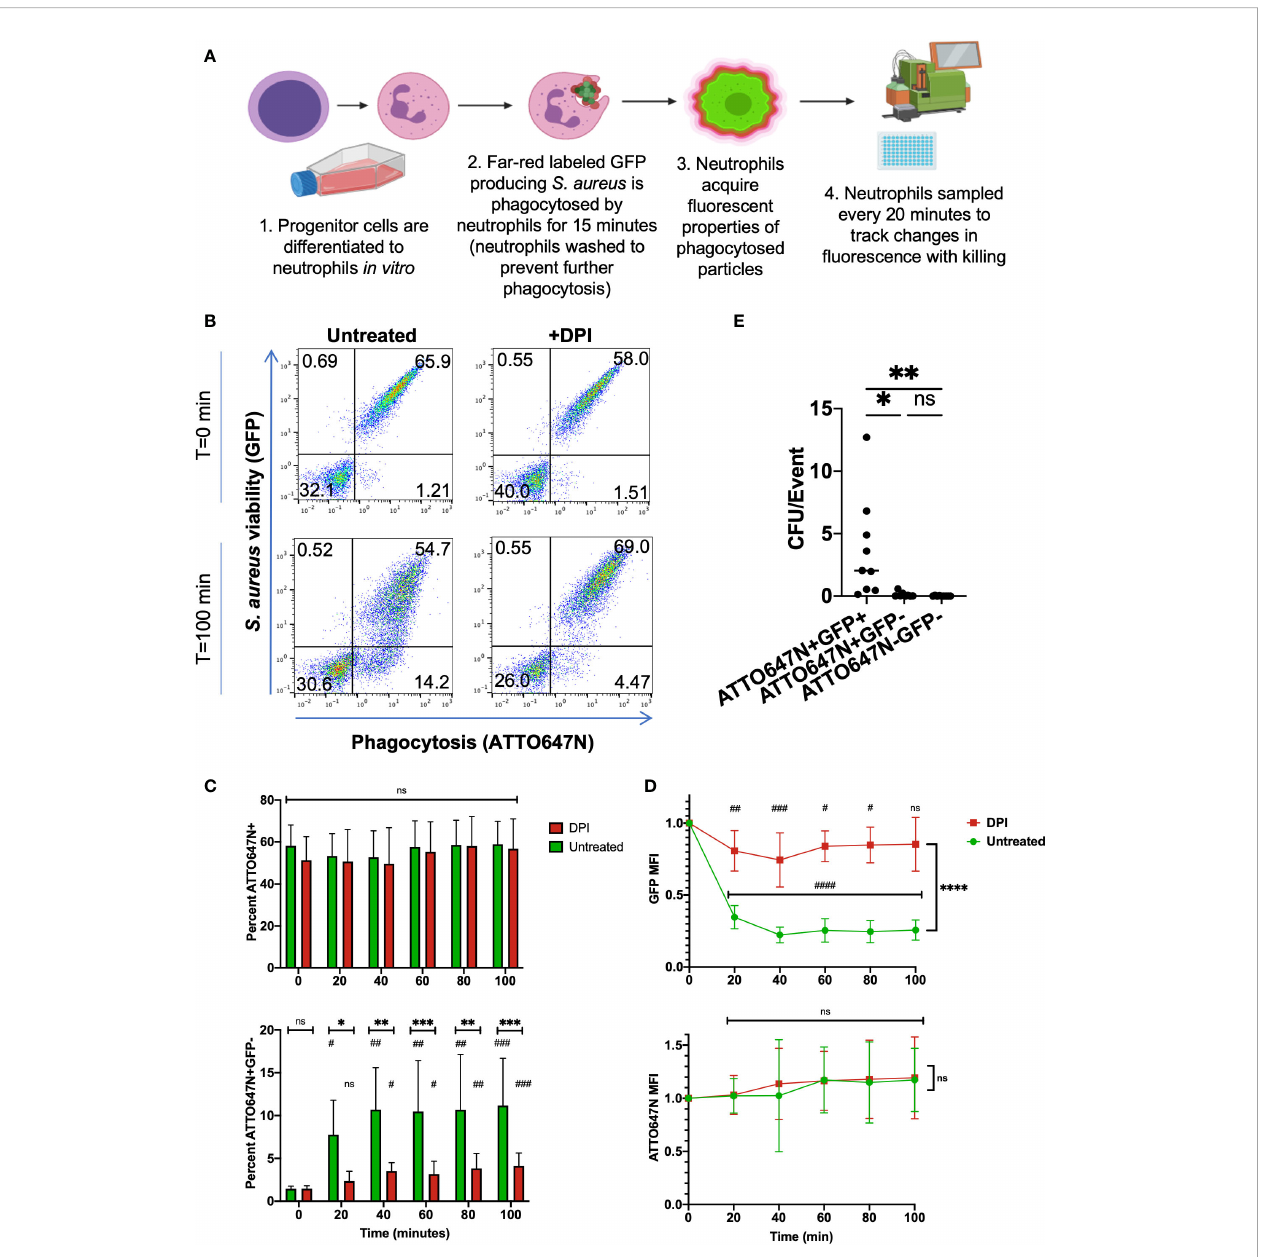
FIGURE 2 In vitro killing assay of bi- fl uorescent S. aureus. (A) Schematic of in vitro screening process of bi- fl uorescent S. aureus. (B) Immediately following phagocytosis, HB8 neutrophils are either ATTO647N - GFP - or ATTO647N + GFP + . After 100 minutes, an ATTO647N + GFP - population forms in the untreated group but not the DPI-treated group. (C) The percent of total ATTO647N + HB8 neutrophils remains constant over time with no signi fi cant difference between untreated and DPI groups, or between the initial time point and subsequent time points within each group. Meanwhile, the percent of ATTO + GFP - cells increases over time within each group (statistical signi fi cance indicated by #) and these changes are signi fi cantly greater in the untreated cells relative to the DPI treated cells at each time point (statistical signi fi cance indicated by *) (D) Quanti fi cation of GFP MFI within the ATTO647N + events shows a dramatic loss of fl uorescence over time in the untreated cells compared to the DPI treated cells and compared to the initial time point (the statistical signi fi cance between each time point relative to the initial time point is indicated by #; statistical signi fi cance between the untreated and DPI group is indicated by *). Meanwhile, the ATTO647N MFI remains consistent in both groups (n=9, performed across three independent experiments). (E) Bacterial burden from sorted cell lysates from both DPI treated and untreated cells, normalized to the total number of sorted events (n=9, performed across two independent experiments). “ ns ” (not signi fi cant) for p>0.05, * for p<0.05, ** for p<0.01, *** p<0.001, and **** for